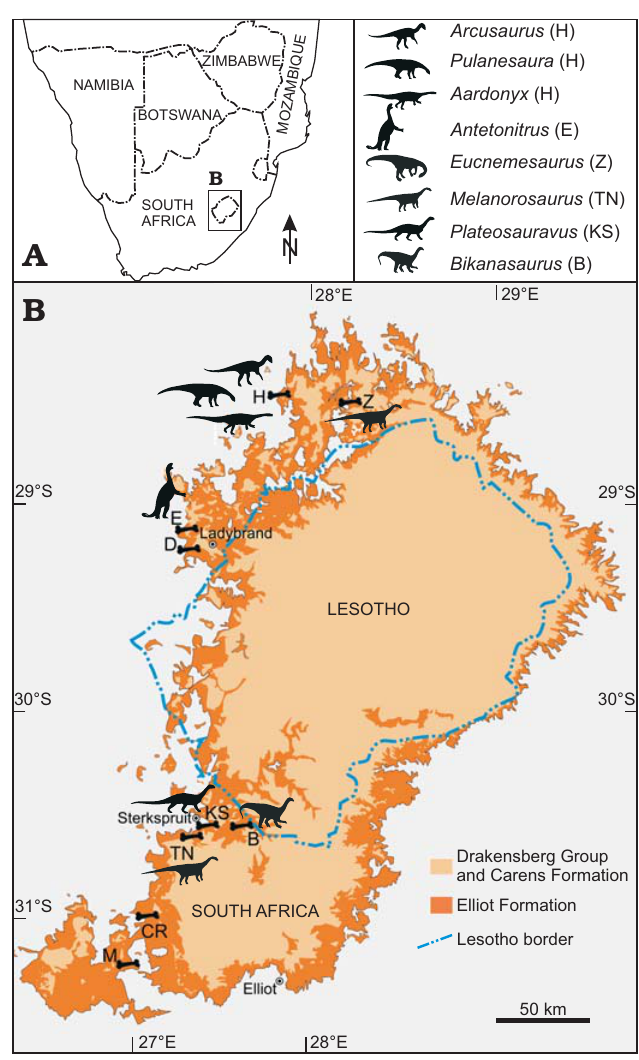
Fig. 1. Overview geological map of the Elliot Formation showing the spa- tial distribution of the fossil localities discussed in the text. Fossil locality abbreviations: B, Blikana; CR, Cannon Rock Farm; D, Damplaats 55 Farm; E, Edelweiss 698 Farm; H, Heelbo (Spion Kop 932) Farm; KS, Kromme Spruit; M, Milner Farm; TN, Thaba ’Nyama; Z, Zonderhout 291